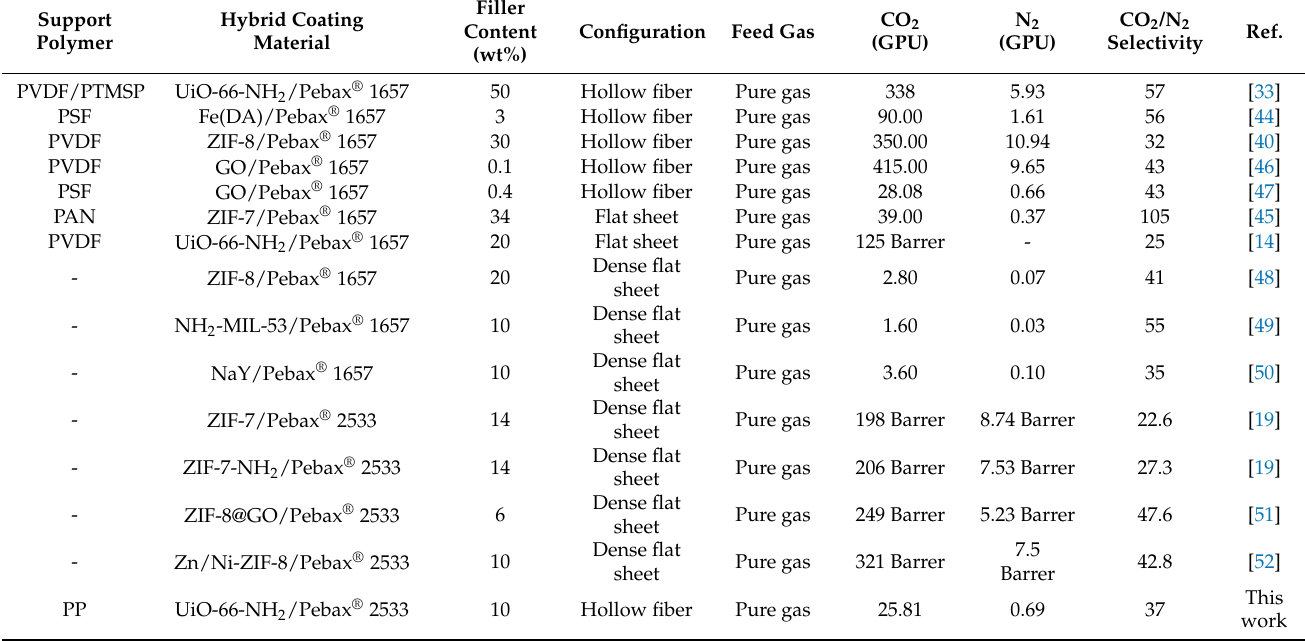
Table 1. The comparison of gas separation performances of Pebax ® -based mixed matrix membranes with different fillers. Support Hybrid Coating Polymer